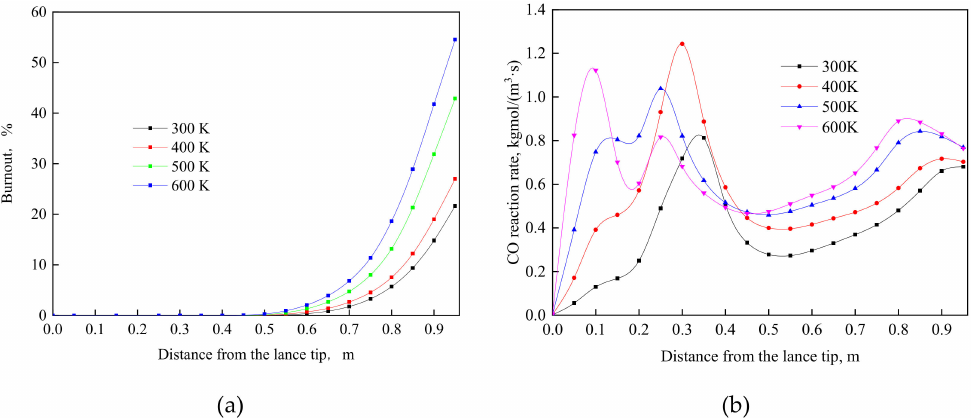
Figure 10. E ff ect of oxygen temperature on ( a ) coal burnout at di ff erent positions; ( b ) CO combustion rate at di ff erent